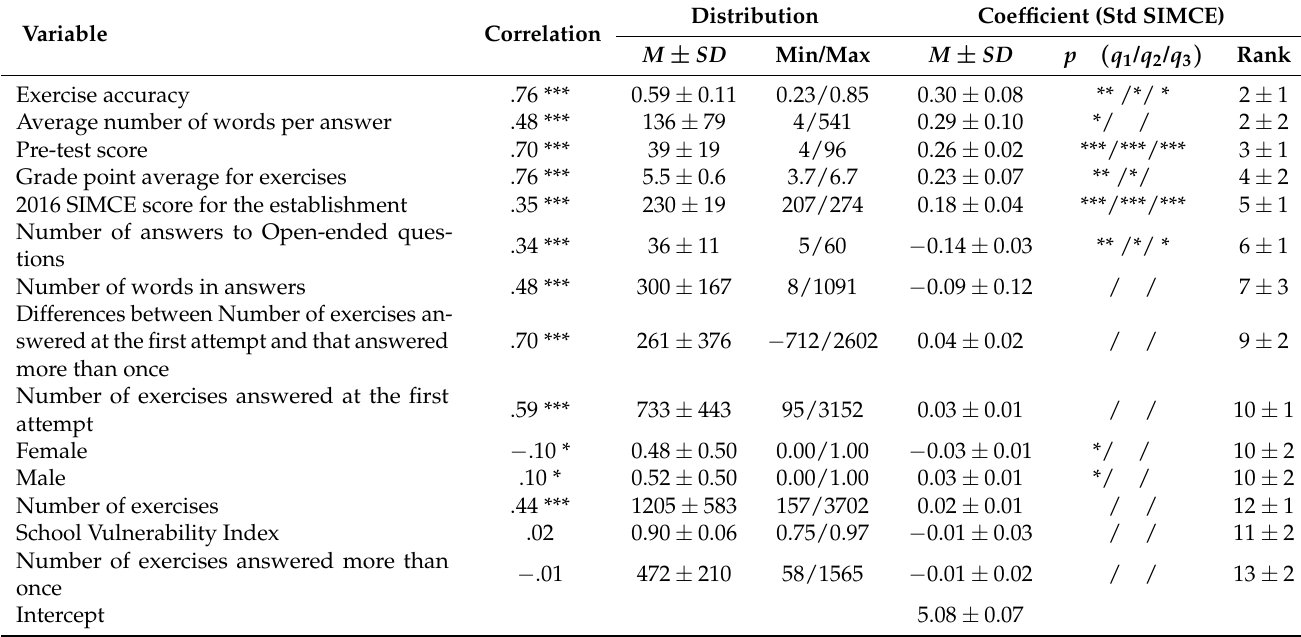
Table 3. Description of regressors for the baseline model. Correlation corresponds to the Pearson coefficient between the regressor and SIMCE score. Coefficient is the average value of the coefficient associated with the regressor divided by SIMCE standard deviation (47.80 reported in Ulloa Miranda 2021). Rank is the average value of the relative weight (less is better) of the modulus of the coefficient associated with the regressor for each fitted model. Both the Coefficient and the rank are obtained from 250 four-fold